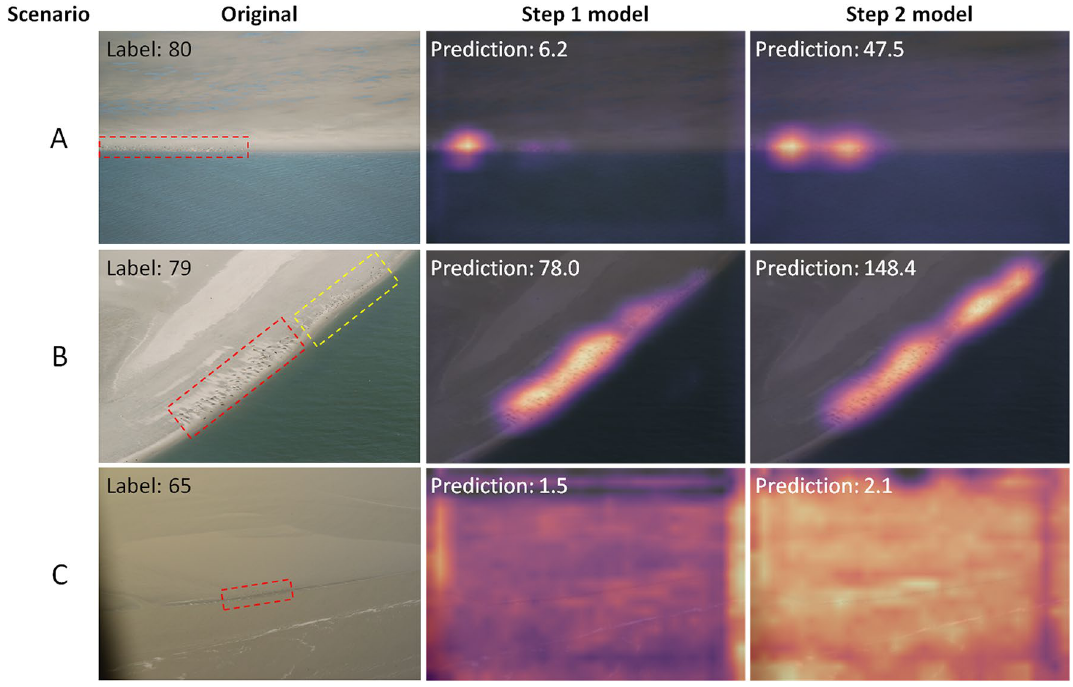
Figure 5. Examples of CAMs for cases with unsatisfactory performance. The first column shows the unedited aerial images, where the red dotted line marks the area where the seals are visible. The second and third columns show the heatmaps when predictions are made using the Step 1 and Step 2 model, respectively. For case ( A ) (small seals) the performance increased, but is still unsatisfactory, as seals remain only partially detected. For case ( B ) the performance decreased as birds (yellow dotted line) start to contribute to the predictions, while for case ( C ) (blurry and extremely small seals) the performance was poor for both